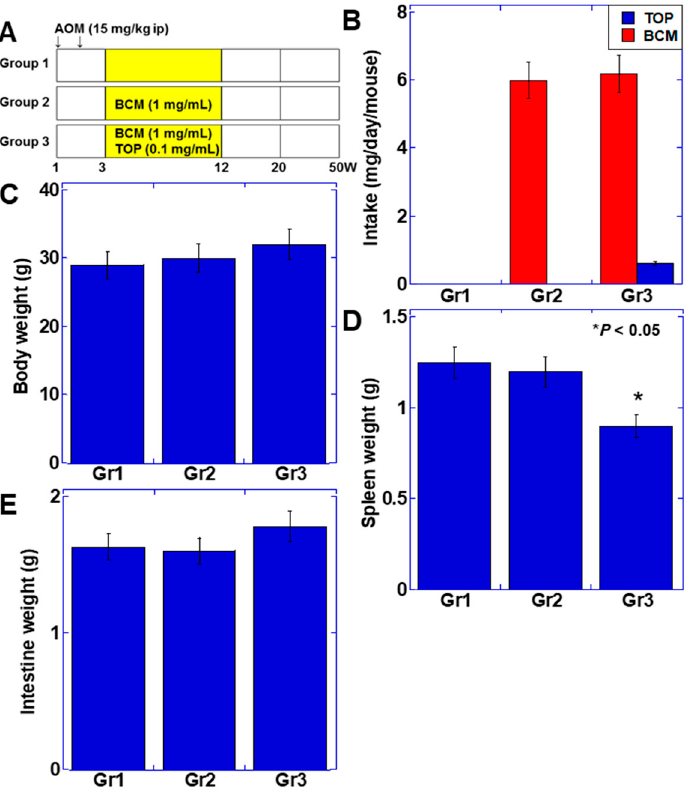
Figure 3. Effect of BCM on colon mouse carcinogenesis model. ( A ) AOM-injected BALB/c mice were treated with BCM+TOP mixed in drinking water. ( B ) Intake of BCM and TOP in each group. ( C – E ) Weights of the body, spleen, and intestine at week 50. Error bar, standard deviation from three independent trials. BCM, β -casomorphin-7; CD, cluster of differentiation; TOP, thiorphan; AOM, azoxymethane; Gr, group.